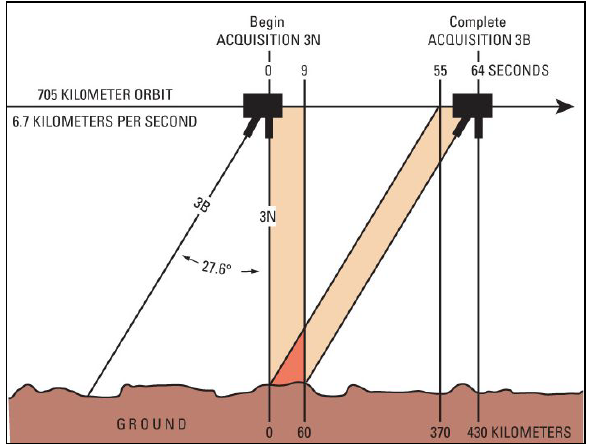
Figure 1. Viewing geometry for ASTER stereo data acquisition. Nadir- and backward-looking telescopes image the same area, 64 seconds apart.